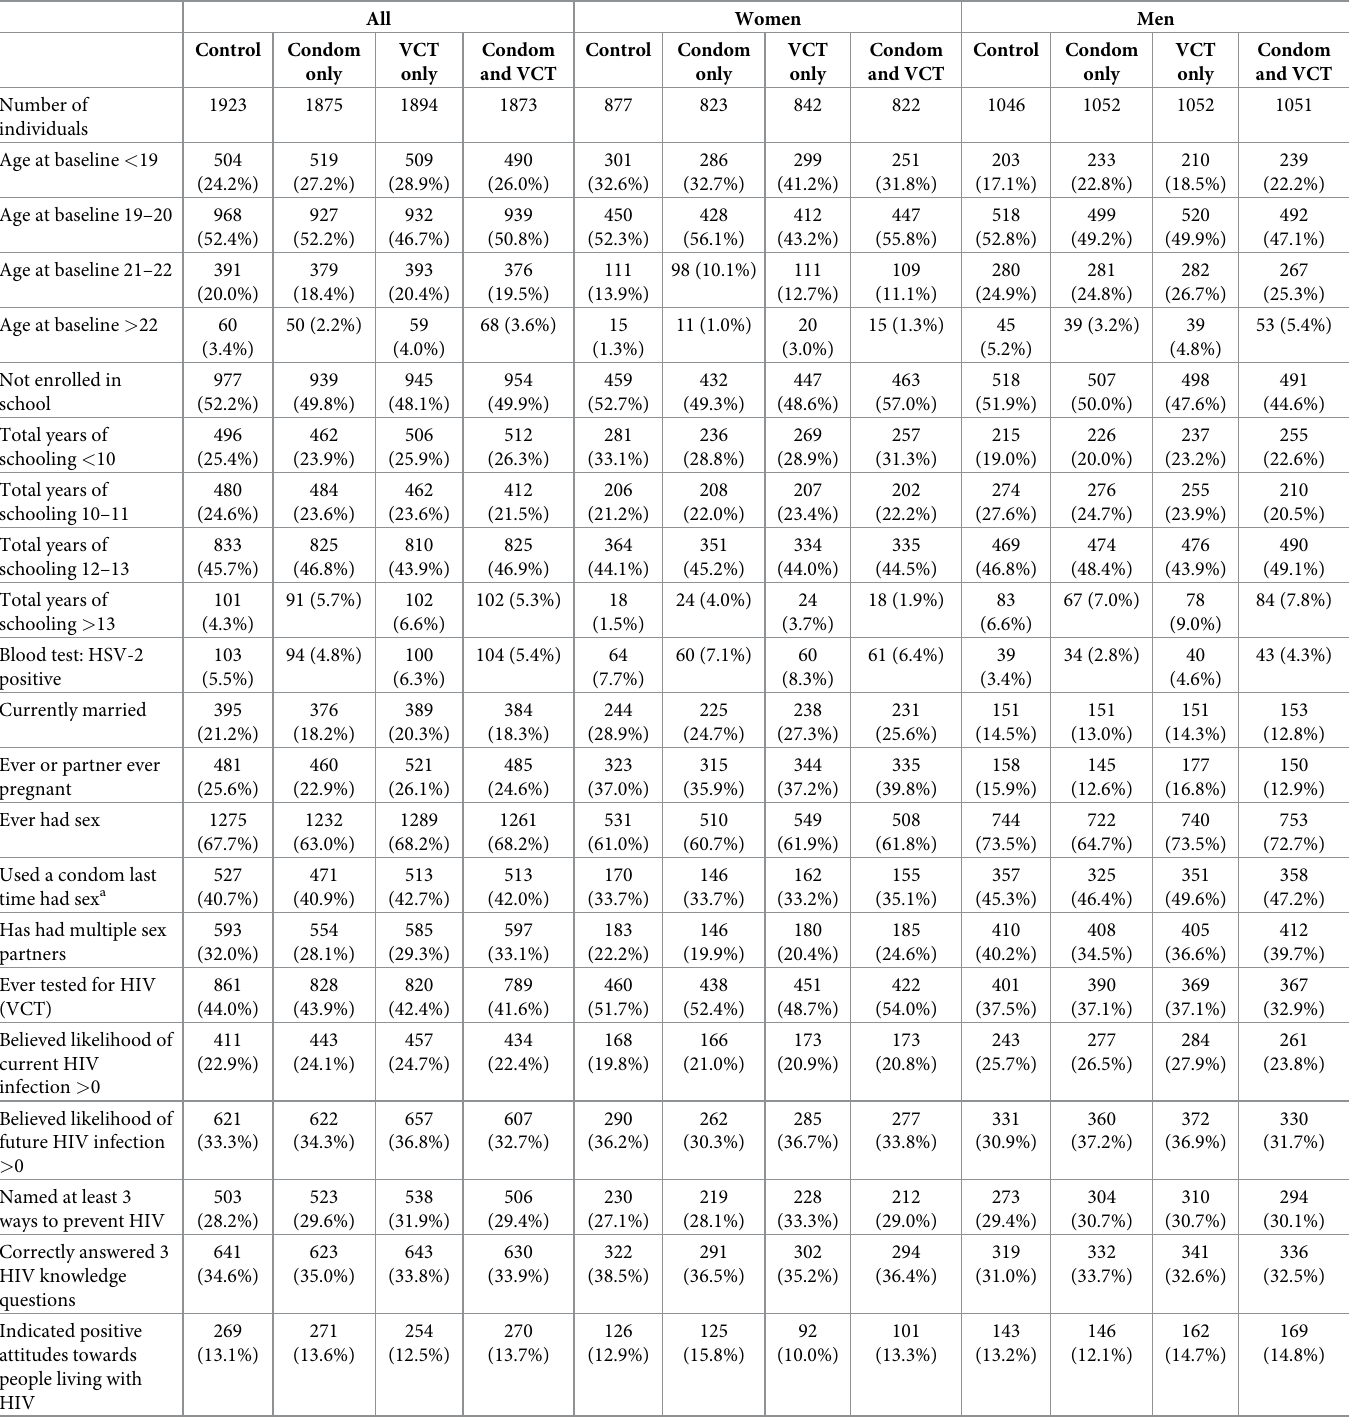
Table 1. Baseline characteristics of those surveyed at follow up.